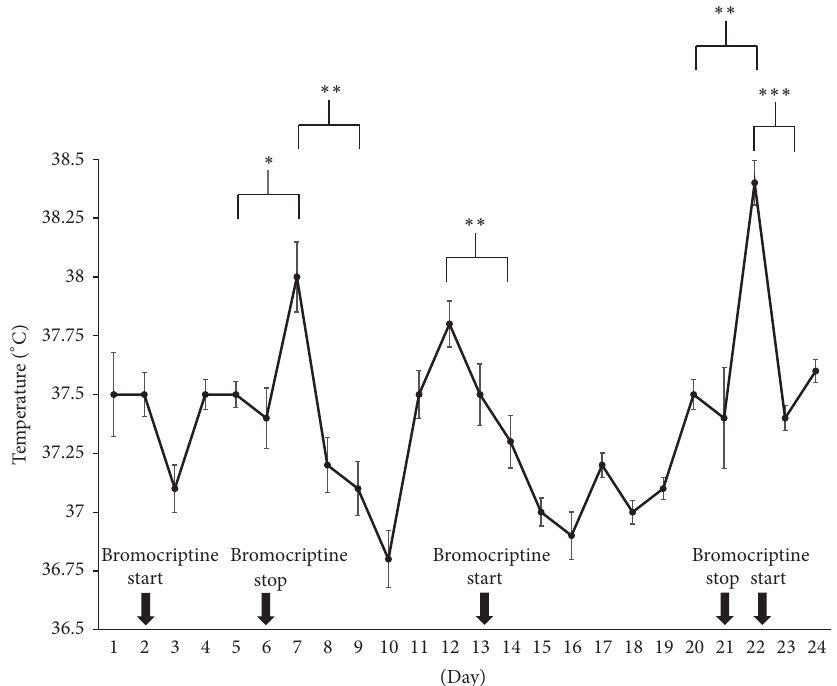
Figure 2: Temperature graph. Average core temperature for each day during hospital course is graphically shown. Error bars are standard errors of the mean. Bromocriptine was started on days 2, 13, and 22. It was stopped on days 6 and 21. Immediately after discontinuation of bromocriptine, there was a significant increase in core temperature. After resuming bromocriptine, there was a significant decrease in core temperature. ∗ 𝑝 < 0.05 , ∗∗ 𝑝 < 0.001 , and ∗∗∗ 𝑝 < 0.0001